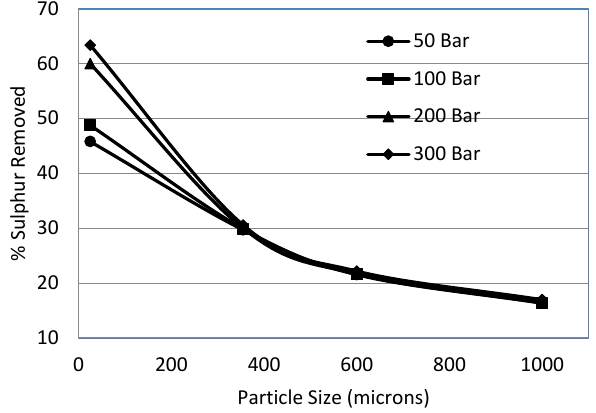
Figure 11. Effect of particle size on organic sulphur removal.